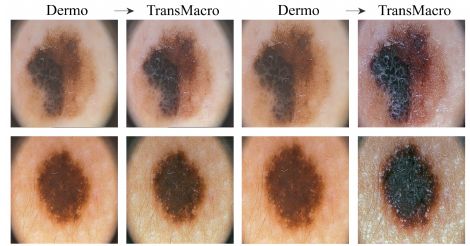
Figure 5. Examples of successful (column 1 and 2) and failure cases (column 3 and 4) of translation from the dermoscopic domain to the macroscopic domain in the PH2 test subset. From Left to right: pair Dermo → TransMacro, cropped pair Dermo → TransMacro.